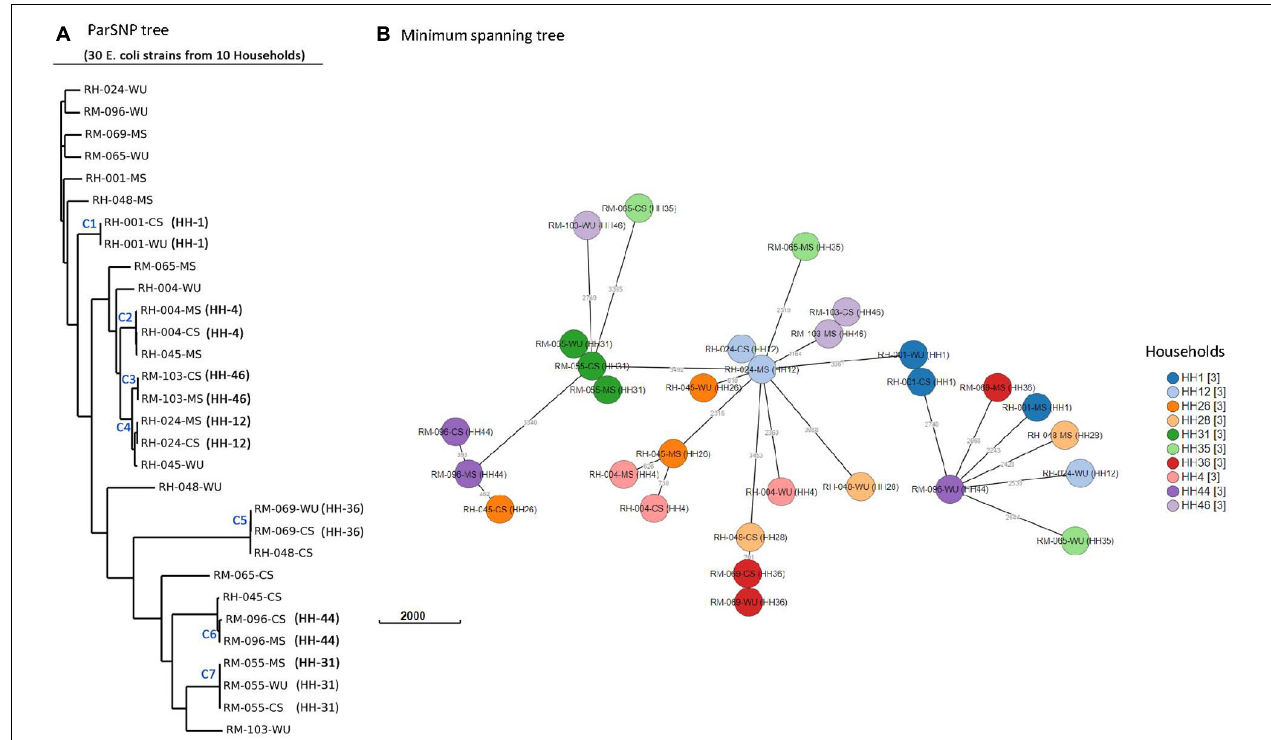
FIGURE 4 | Phylogenetic analysis of 30 E. coli isolates. (A) Core-genome SNP tree using ParSNP alignment. (B) Minimum spanning tree generated by wgMLST. Isolates from same household are shown by circles of identical color. Numbers next to branches indicate allelic differences according to wgMLST